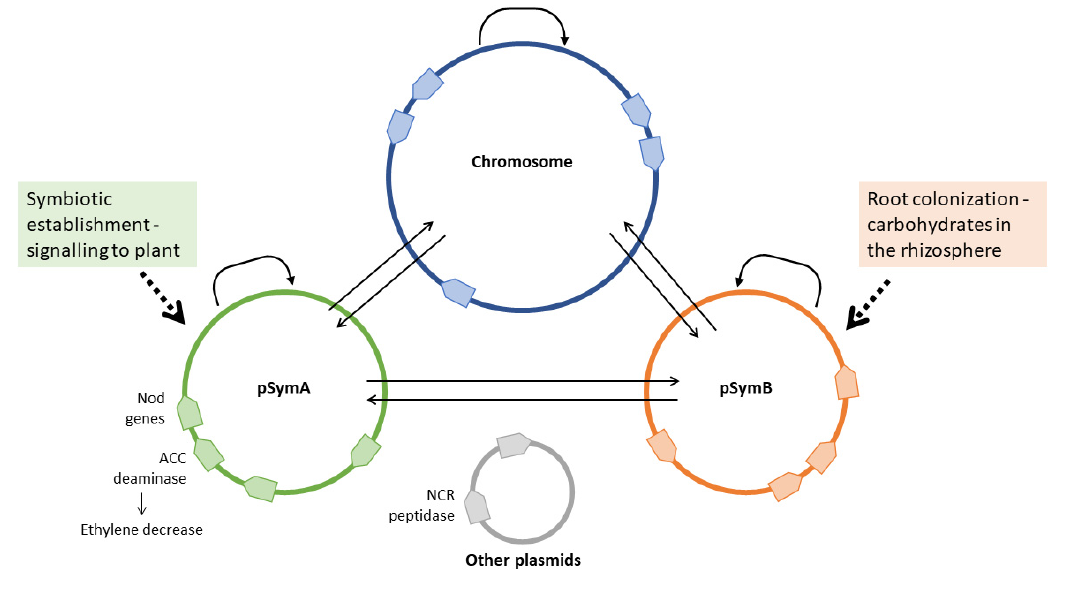
Figure 2. Partition and interaction among replicons in host genotype-specific interaction. The exam- ple reported refers to the Sinorhizobium meliloti genome, composed of a chromosome, a chromid (pSymB), a megaplasmid (pSymA) and often smaller accessory plasmids. Arrows connecting repli- cons are based on gene interaction data from [74,130,131].